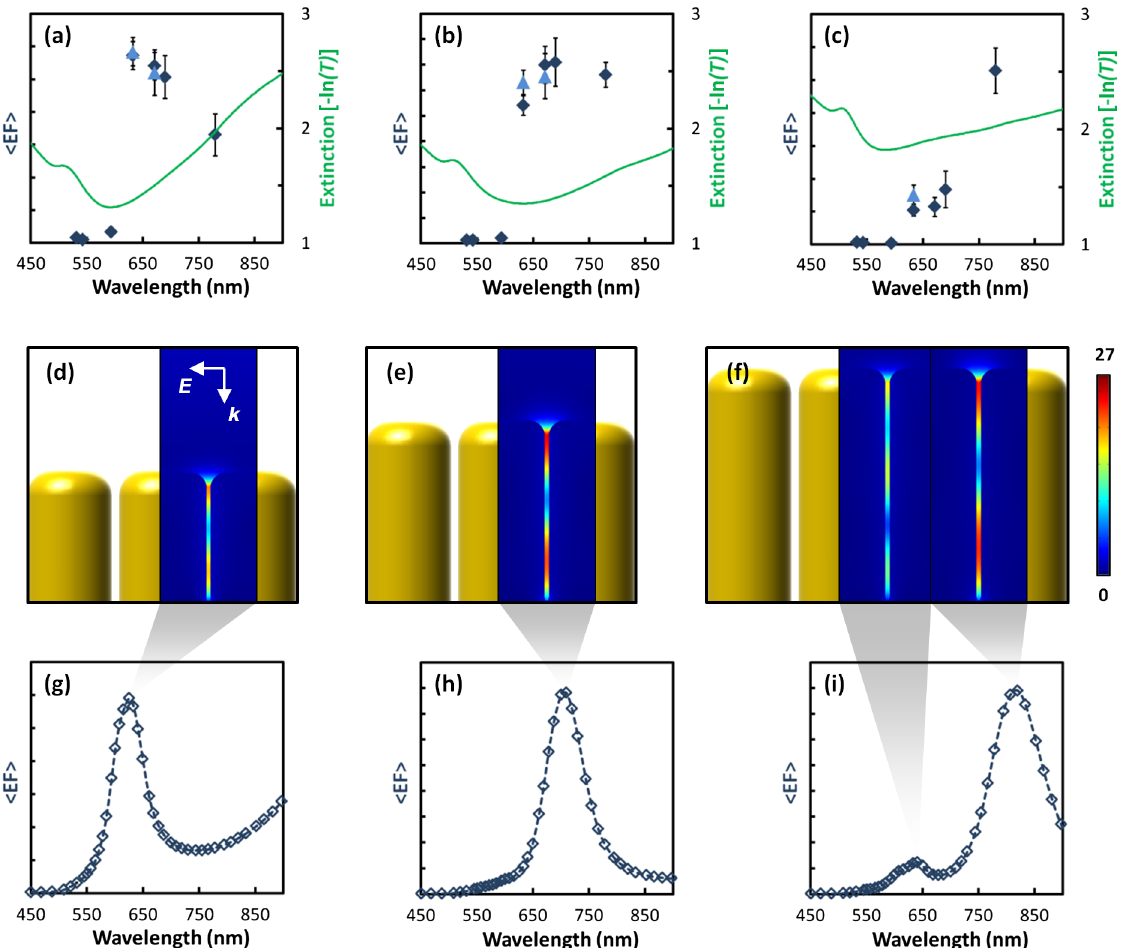
FIG. 4. Graphs of the observed and modeled enhancement factor, demonstrating the effect of the cavity mode on SERS. (a)–(c) Graphs comparing the measured enhancement factor h EF i and optical extinction [ (cid:1) ln ð T Þ ] at normal incidence for nanorods with an average diameter of 48 nm; array period of 64 nm; and average lengths of (a) 85, (b) 125, and (c) 160 nm. The green lines indicate the optical extinction. Black-diamond and blue-triangle data points indicate the h EF i of the 915 - cm (cid:1) 1 band of CV and the 775 - cm (cid:1) 1 band of R6G, respectively. (d)–(f) Schematics of the modeled nanorod structures with 3-nm separation; array period of 64 nm; and lengths of (d) 85, (e) 125, and (f) 160 nm, overlaid with plots of local field on excitation of the third harmonic of the cavity. The fifth harmonic is also shown in (f) for the longest nanorods. (g)–(i) Graphs displaying the EF predicted by the finite-element- method modeling for the nanorods shown in (d)–(f). The hollow diamond data points indicate the predicted enhancement factor for an imaginary 850 - cm (cid:1) 1 Raman band. All enhancement factors are plotted at the excitation